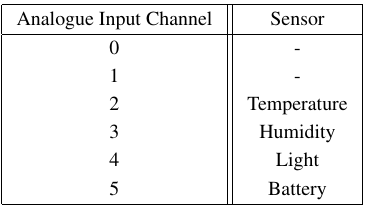
Table 2. Sensor connectivity to the diecemila